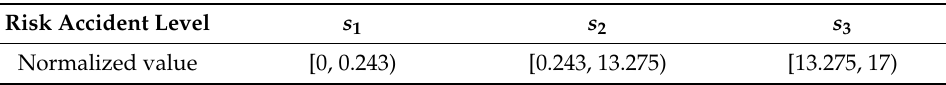
Table 5. Classification standard of safety risk